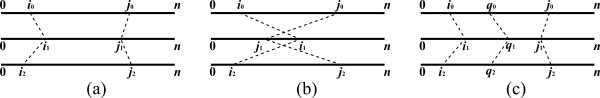
Multiple String VMT. (a) An example of a Multiple String VMT instance, with three strings. A sub-instance SX, Y consists of three substrings (where X = {i0, i1, i2} and Y = {j0, j1, j2}). (b) Here, since j1 < i1 we have that X ≰ Y, and thus SX, Y does not correspond to a valid sub-instance. (c) A valid split of the sub-instance is obtained by splitting each one of the corresponding substrings sip,jpp into a prefix sip,qpp and a suffix sqp,jpp.